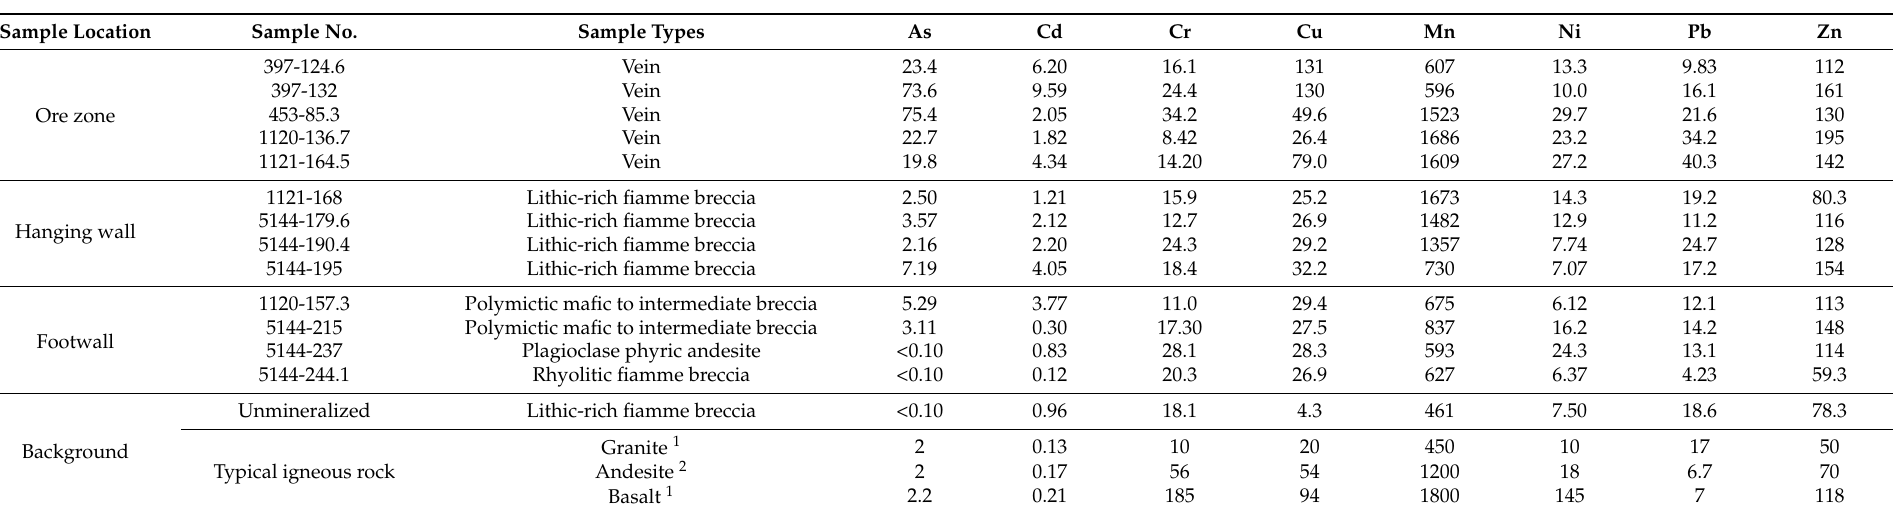
Table 4. Trace metal and metalloid concentrations (mg/kg) in the representative samples from the H ore lens, with values of typical igneous rocks. Sample